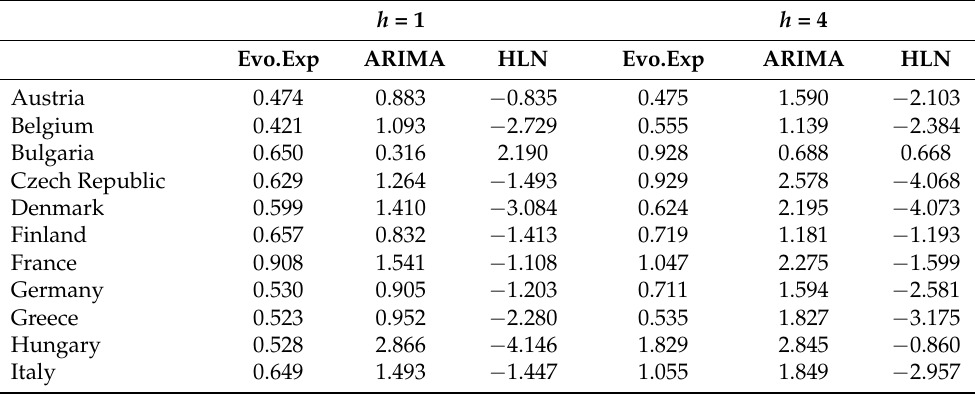
Table 4. Forecast accuracy (RMSFE): Iteratively evolved expectations (Evo.Exp) vs. ARIMA. h =